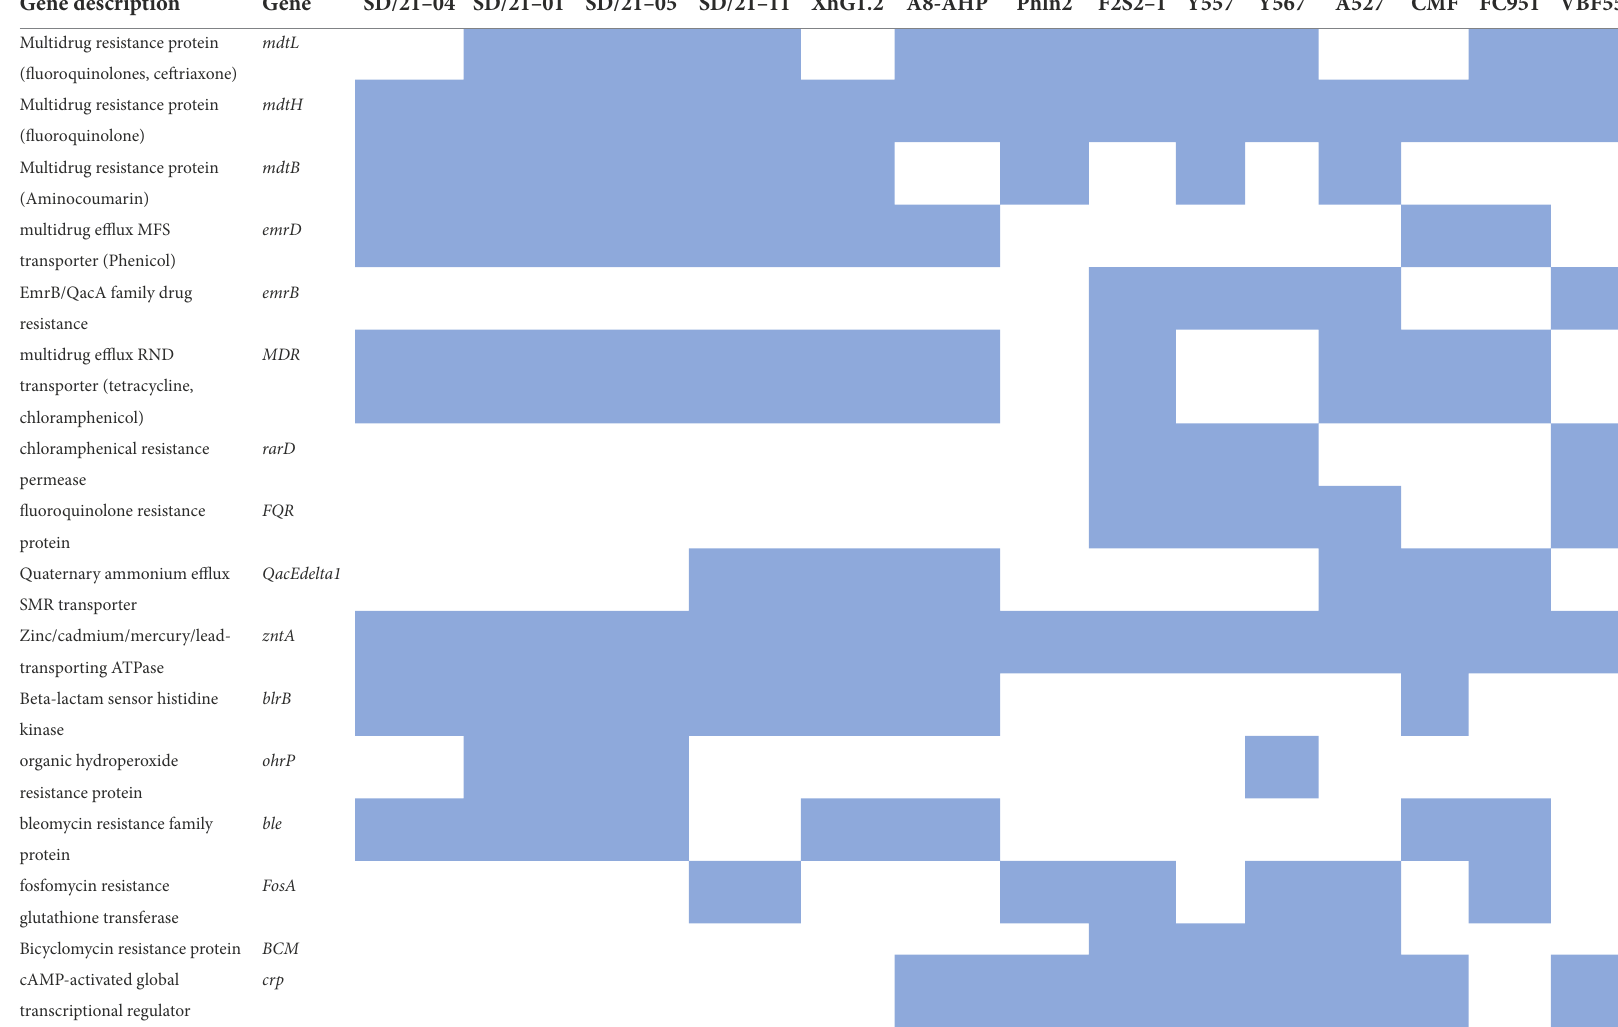
TABLE 5 Multidrug efflux pump genes detected in Aeromonas